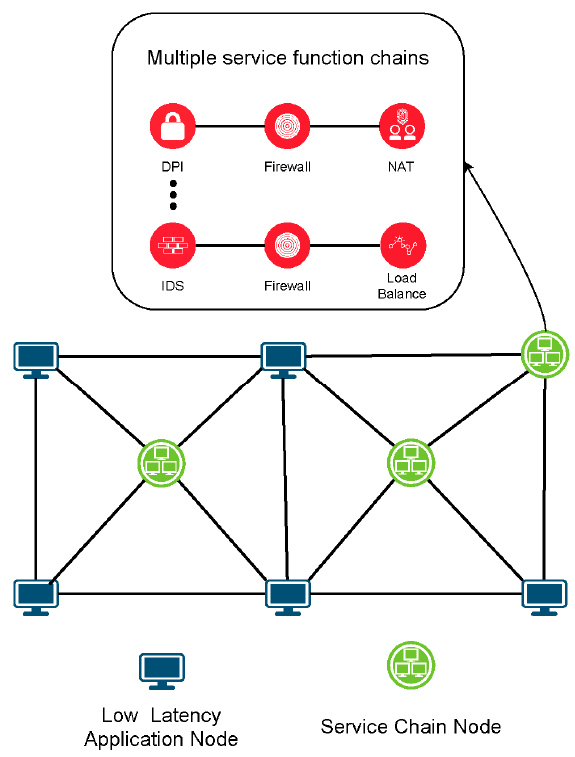
Figure 4. LLS model.